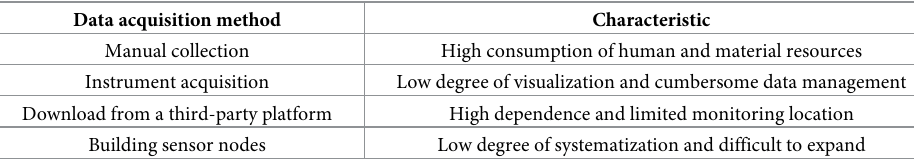
Table 1. Status of dust data